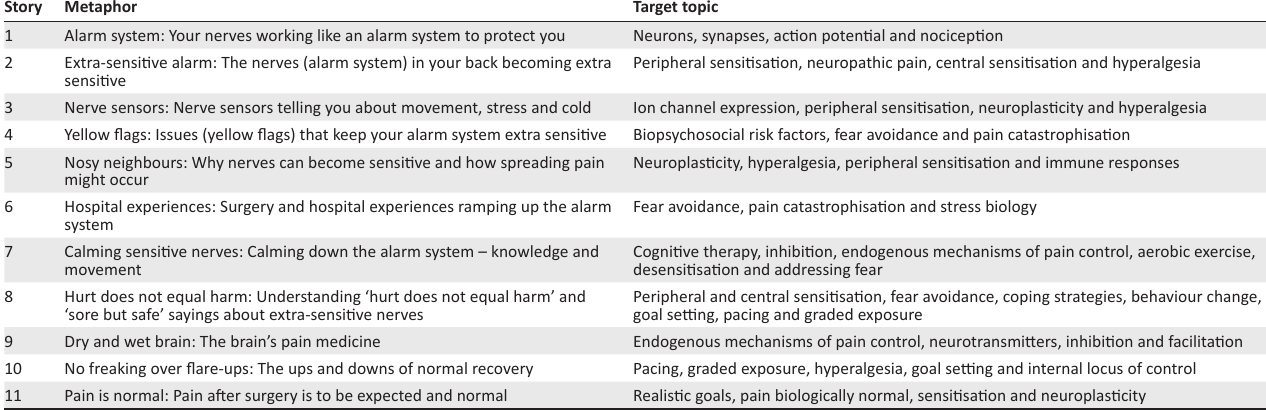
TABLE 1: Description of the metaphors and target topics used in the preoperative pain neuroscience education. Story